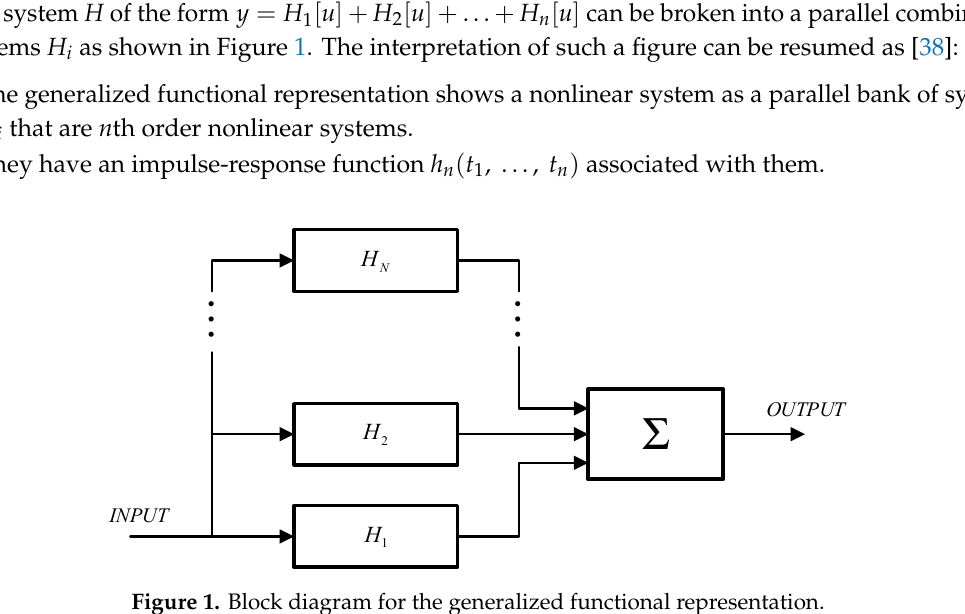
Figure 1. Block diagram for the generalized functional representation.